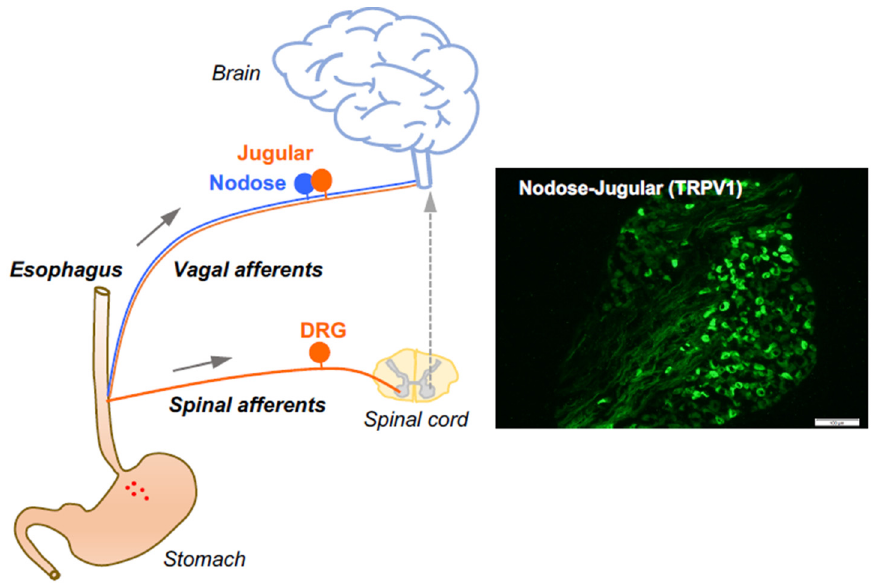
Figure 1. Esophageal primary afferent pathways. The extrinsic primary afferent nerves in the esophagus include vagal and spinal afferents with their neuronal cell bodies in nodose and jugular ganglia (NJG) and dorsal root ganglia (DRG), respectively. (right: TRPV1 immunoreactivities in mouse NJG, bar size = 100 μ M).